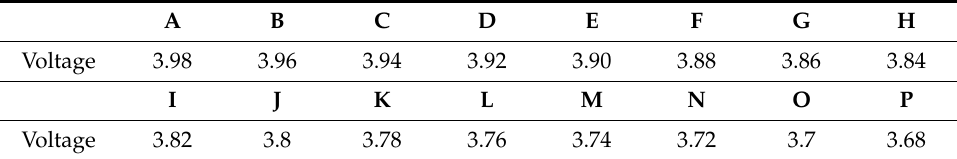
Table 6. The initial cell voltages of sixteen cells (voltage unit: V).